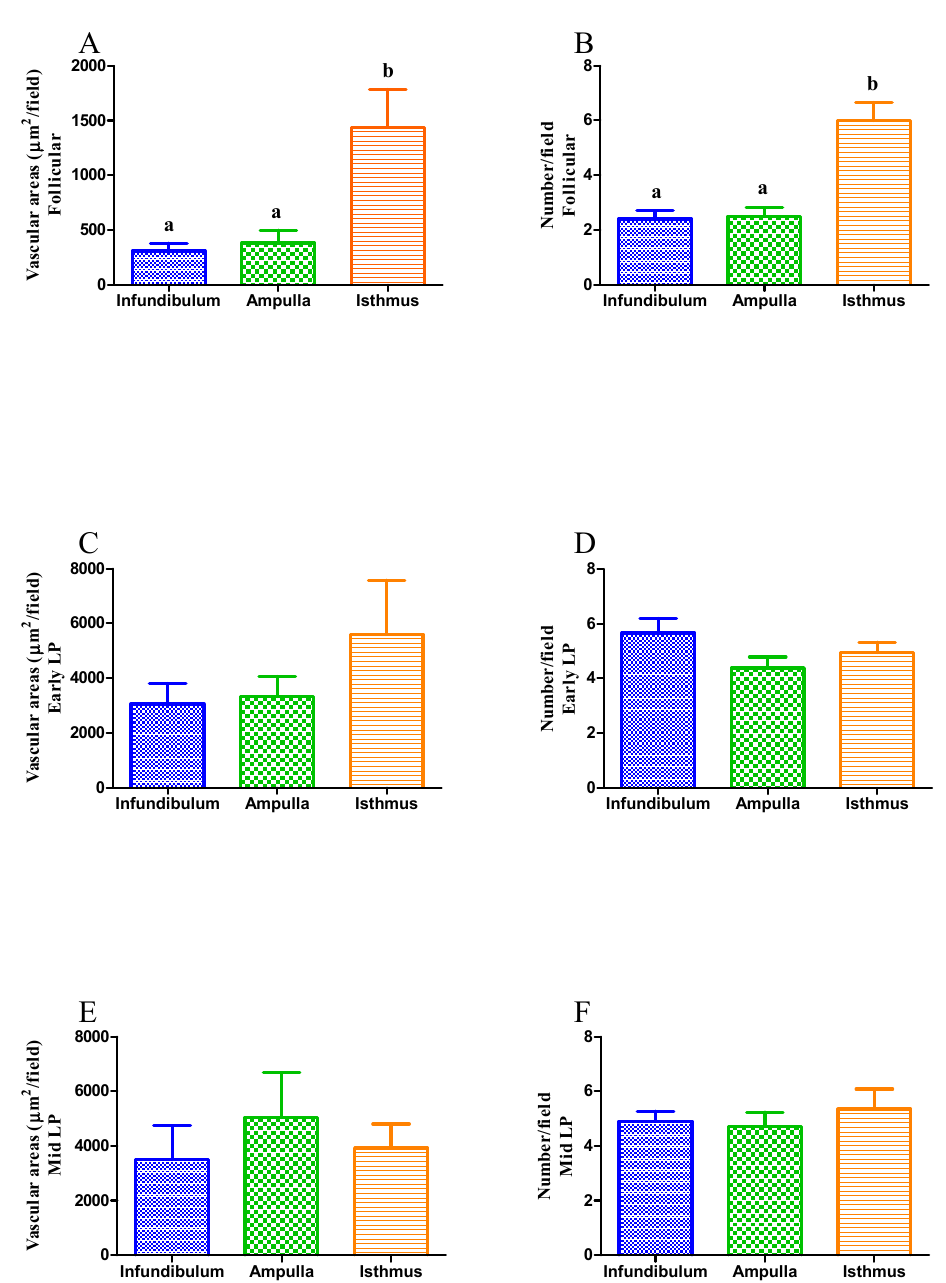
Figure 4. Vascular areas present in the oviduct. Total area of microvascular structures ( A , C , E ) and total vascular structures ( B , D , F ) present in 10 random microscopic fields. Analysis was performed considering samples from each estrous cycle phase: follicular ( A , B ), early-luteal ( C , D ), and mid-luteal phases ( E , F ). Bars represent mean ± SEM. Different letters (a,b) indicate significant differences ( p < 0.05).